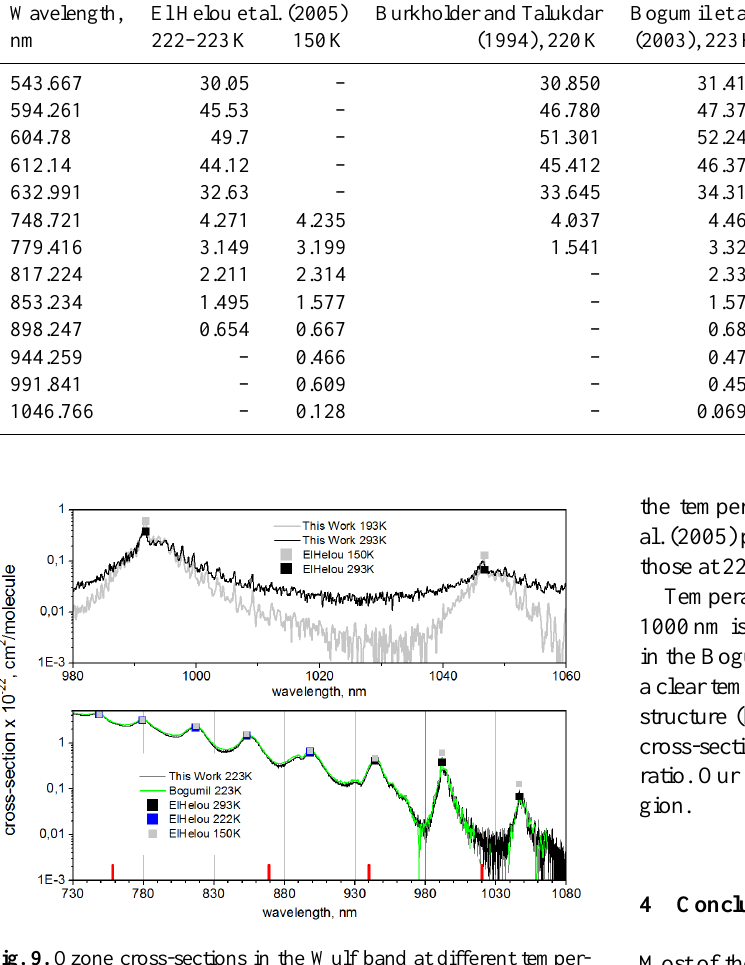
Fig. 9. Ozone cross-sections in the Wulf band at different temper- atures. Lines – new data and Bogumil et al. (2003); squares – El Helou et al. (2005). The spectral channels from SAGE II are indi- cated by short vertical